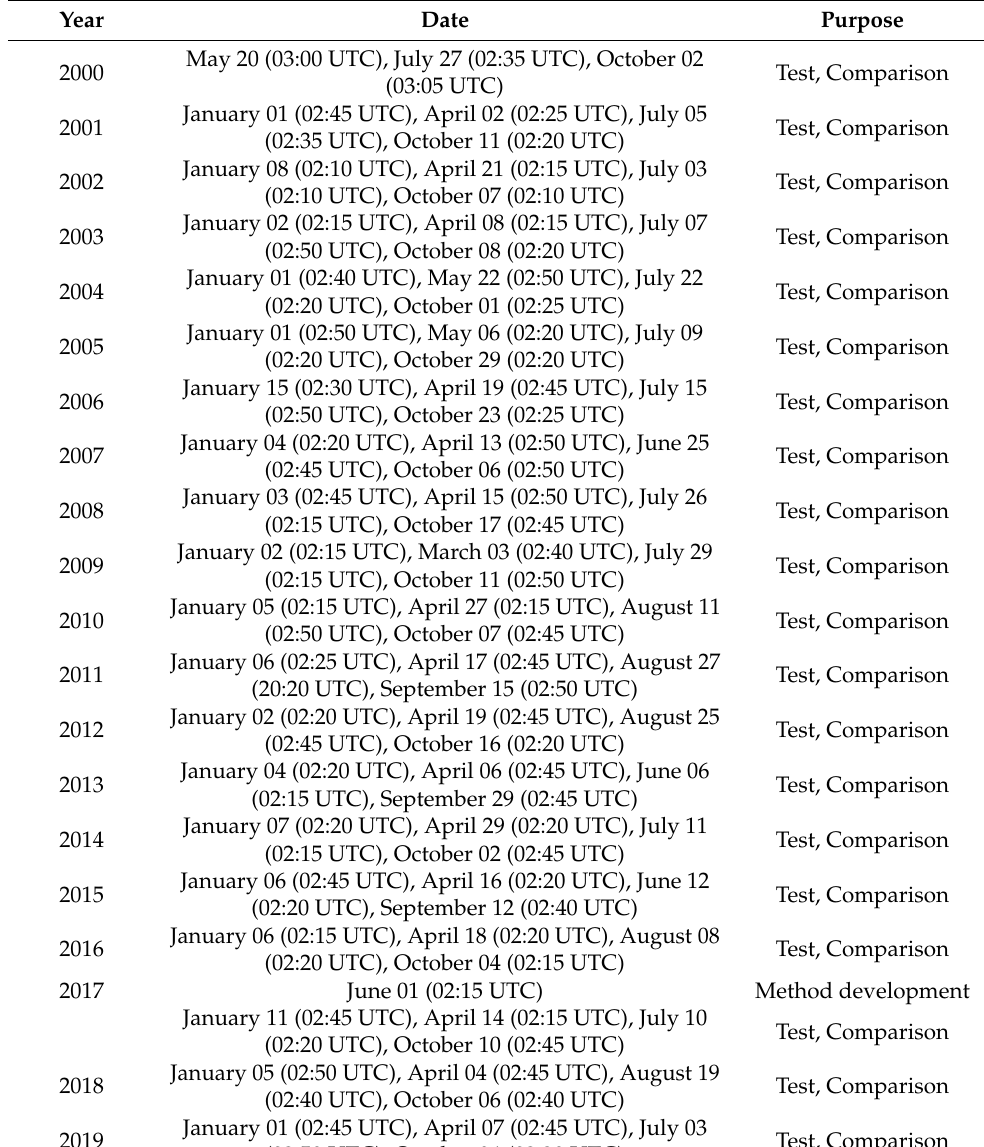
Figure 4. Study area including the Yellow Sea and Bohai Sea. Table 2. Case studies used in this